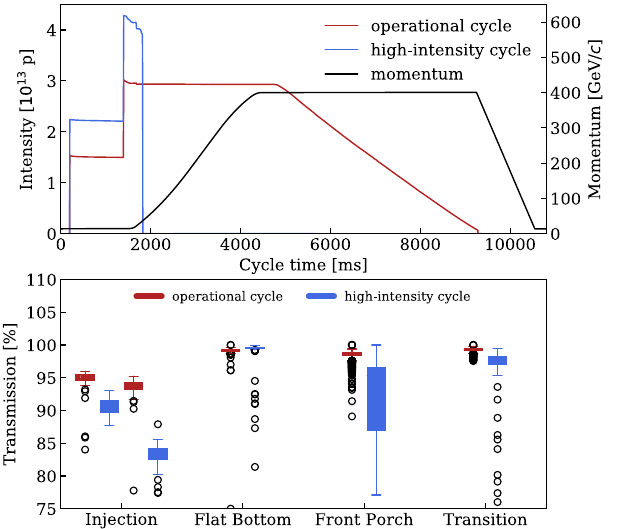
FIG. 15. Upper: SPS magnetic cycle and beam intensity for the operational and the high-intensity cycle. For the case of the high- intensity cycle, the beam is dumped on the energy ramp, which explains the sudden total beam loss. Lower: Beam transmission in the SPS between the various stages of its cycle. The performance at injection is separated into first and second batch injected from the PS. For the remaining three stages, only data where both injections were present were considered. The open circles indicate outliers in the distributions of transmission efficiency.